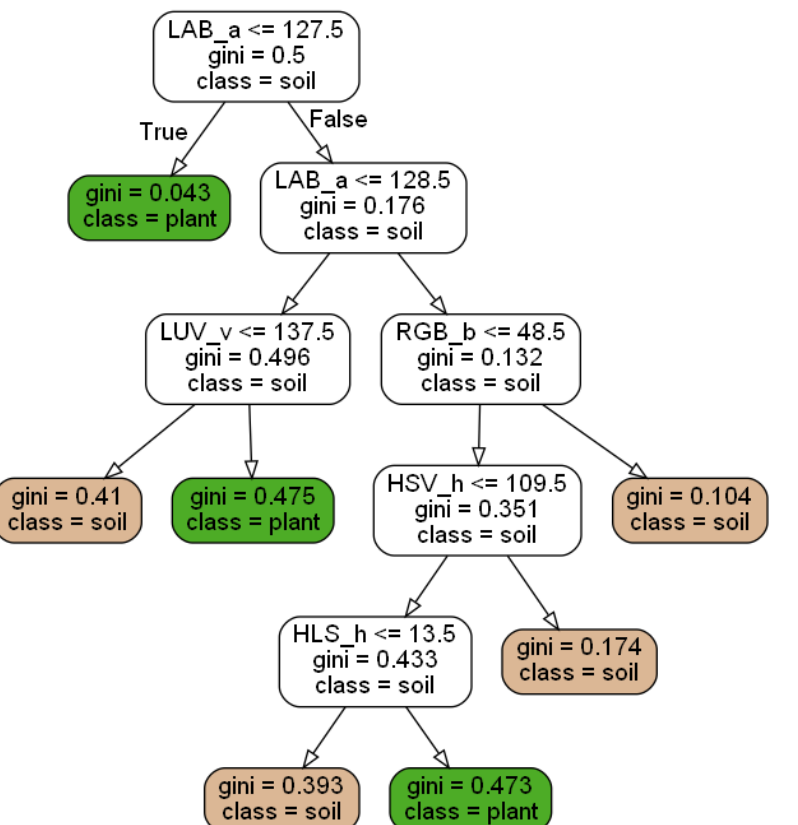
Figure 2. Visualization of exemplary color space decision tree classifier (CSDTC). Each node shows feature/threshold tuple, Gini impurity and major class label. Leaf nodes are colored and finally classify the pixel into plant (green) or soil (brown). Top ranked feature at root node is the value for the a* color channel of the CIEL*a*b* color space. Distinction in lower nodes are made regarding the CIEL*a*b* color space, the CIEL*u*v* color space, the RGB color space, the HSV and HSL color